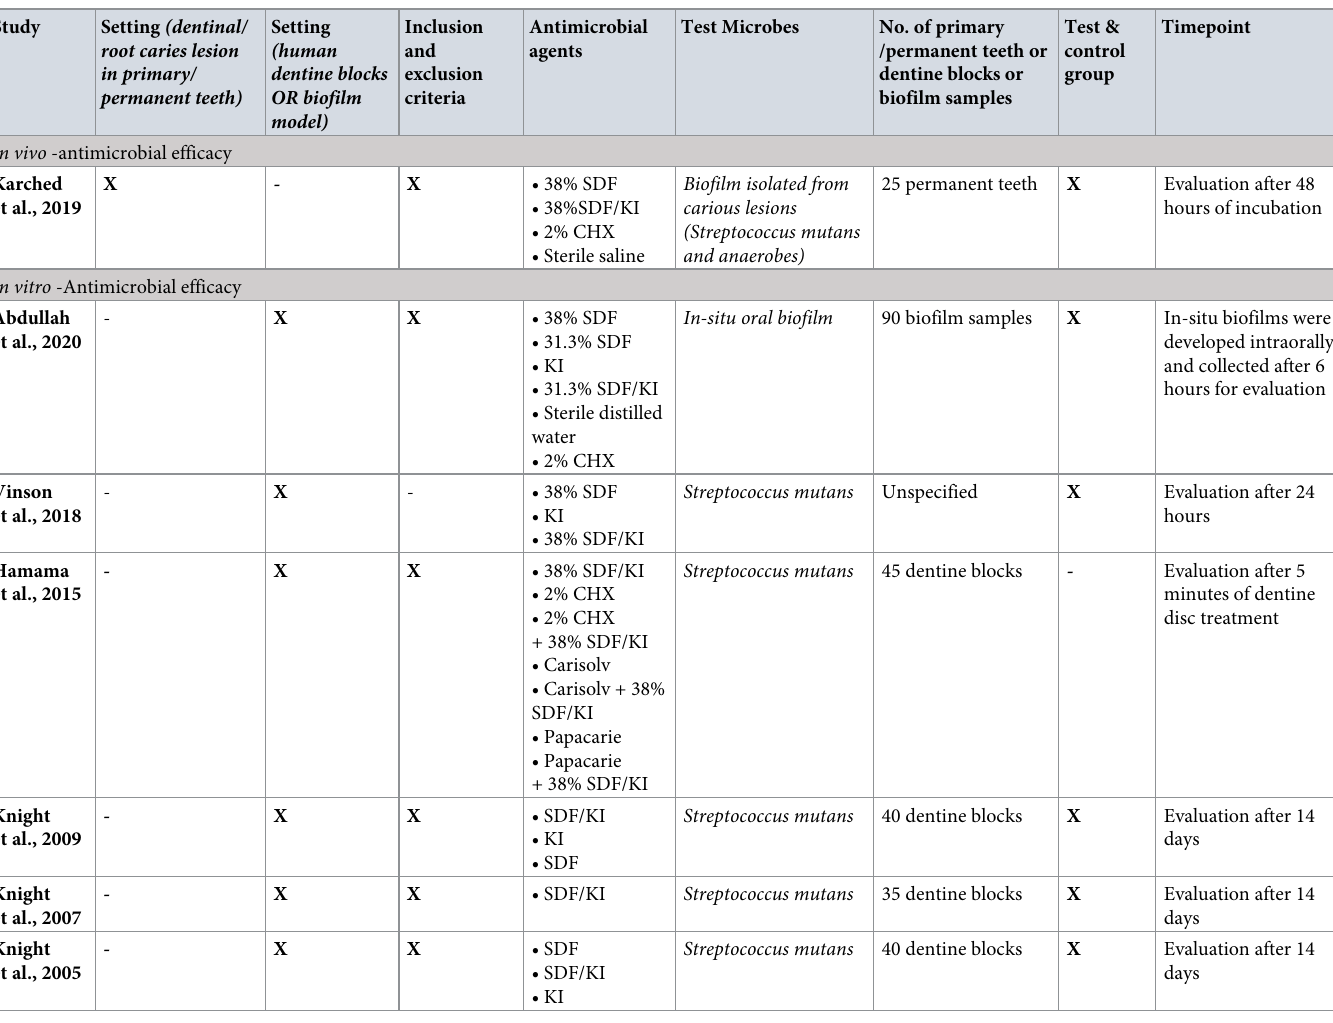
Table 1. Characteristics of the included studies on the antimicrobial effect of